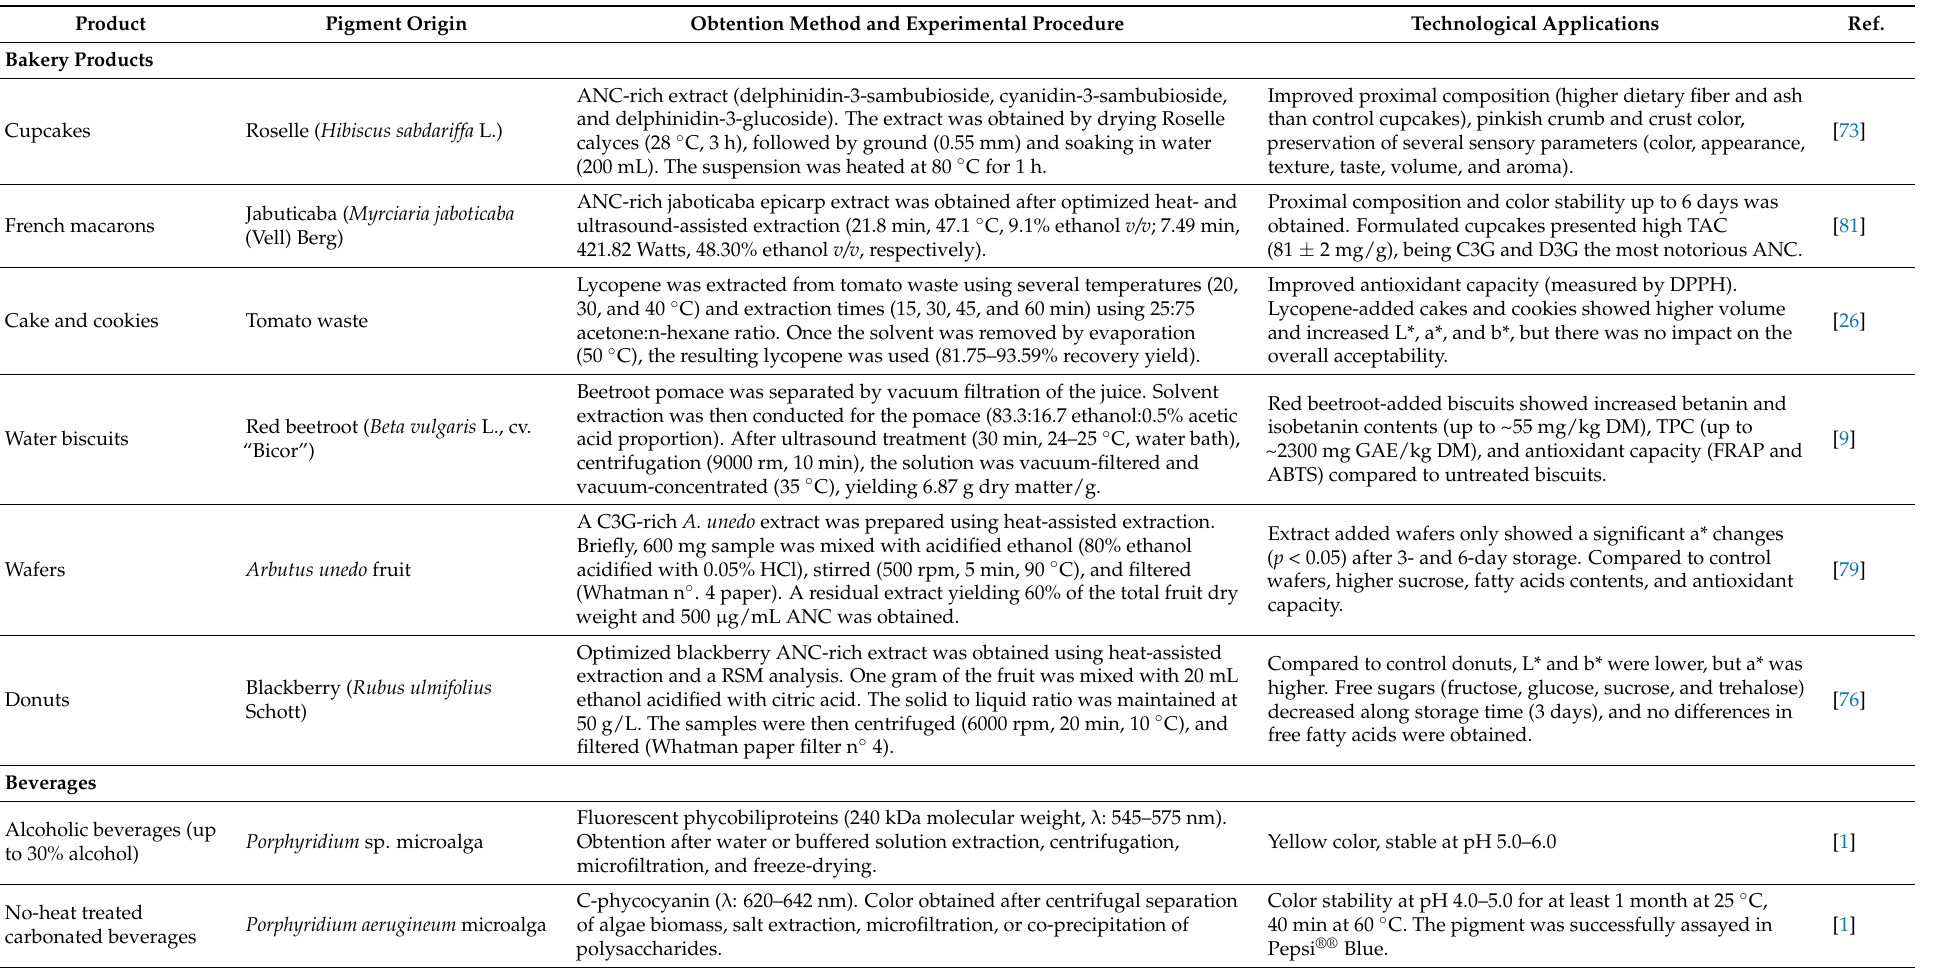
Table 2. Technological applications of natural colorants in food